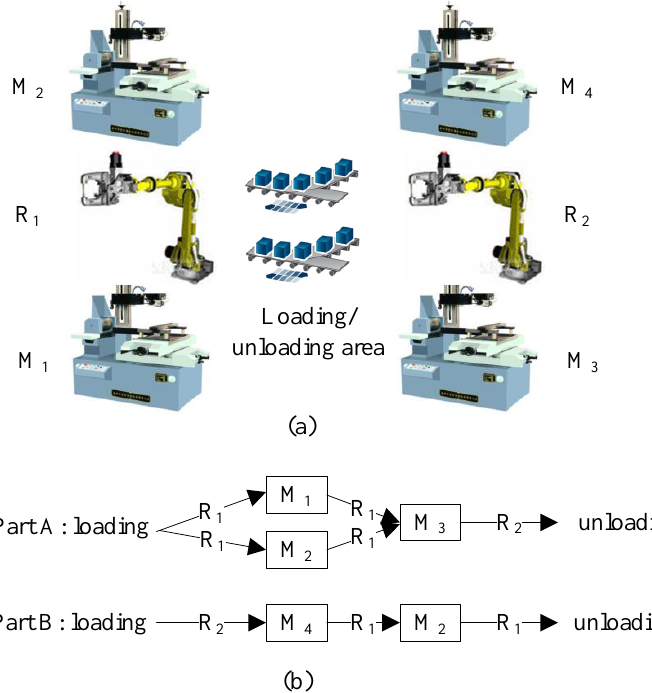
Figure 1. ( a ) An AMS example, ( b ) Production sequence.